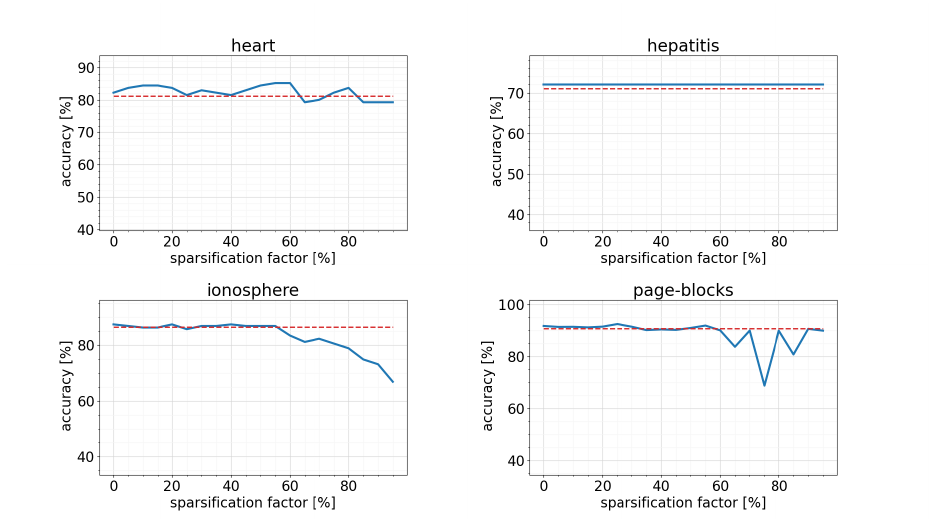
Figure 20. Results of pruning SVM structure on heart, hepatitis, ionosphere and page-blocks datasets.